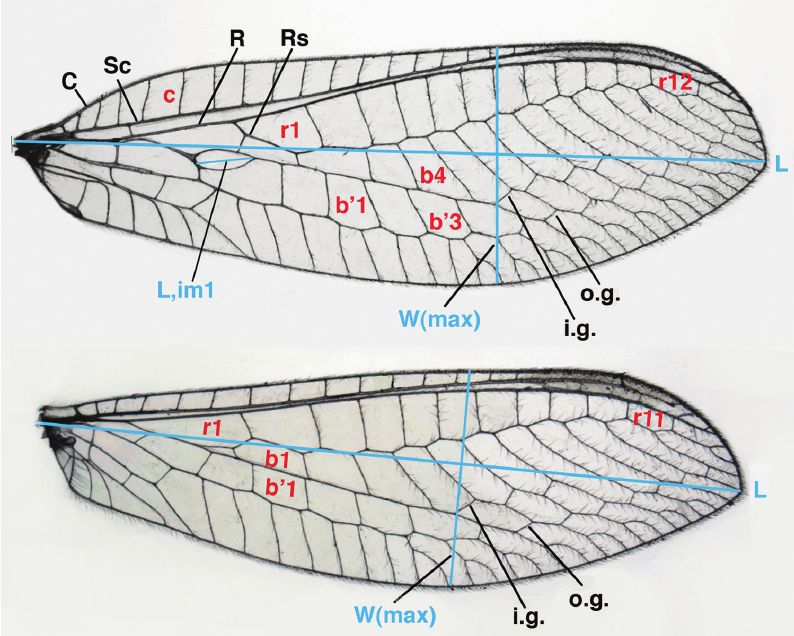
Figure 2. Wing structures and measurements; upper, forewing; lower, hindwing. Veins (black lettering): C Costa Sc Subcosta R Radius Rs Radial sector i.g . inner gradate o.g. outer gradate. Cells (red lettering): b1, b4 first, fourth upper Banksian cells b’1, b’3 first, third lower Banksian cells c costal cell r1, r11, r12 first, eleventh, twelfth radial cell. Measurements (blue lines): L length of wing L,im1 length of first intramedian cell W ( max ) maximum width of